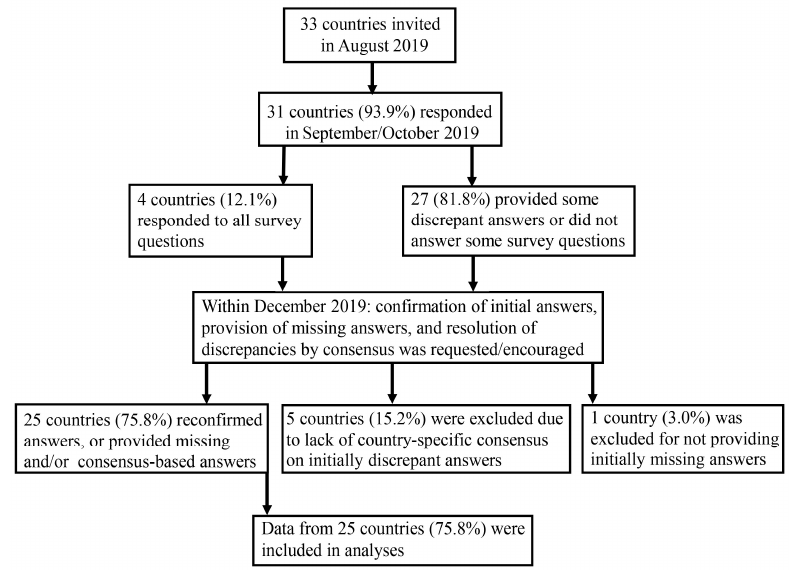
Figure 1. Flow diagram of responses to the 2019 questionnaire.